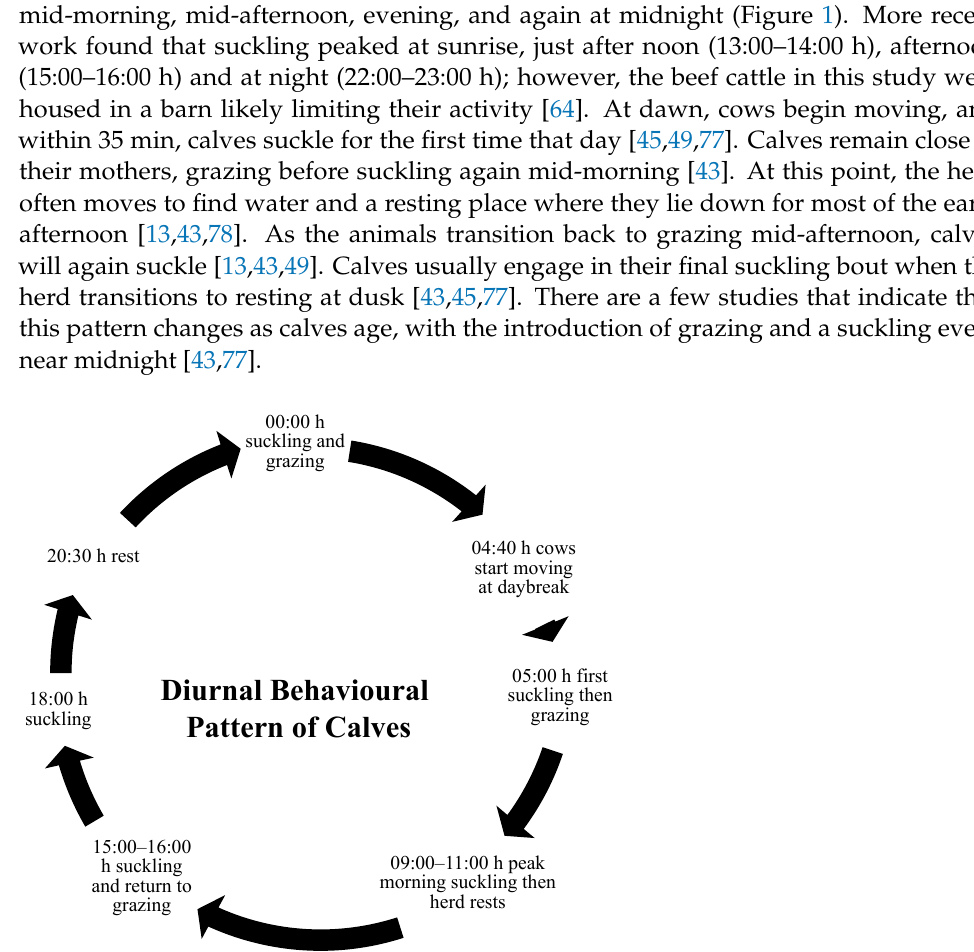
Figure 1. The diurnal behaviour pattern of calves raised with maternal contact on pasture in herds [13,43,45,49].